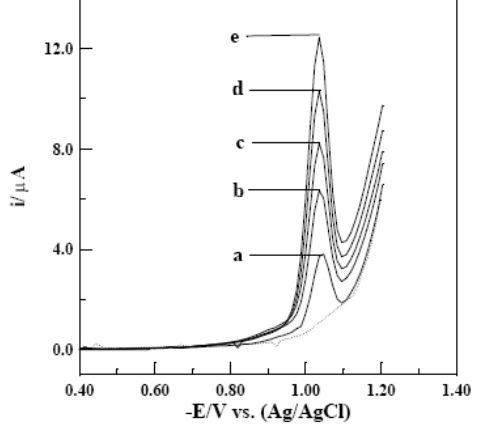
Fig. 6 SW-AdCS voltammograms for various concentrations of tolmetin spiked in human serum recorded after adsorptive accumulation onto the HMDE at E acc = − 0 . 4 V for t acc = 150 s. The dotted line represents the background, (a) 1 3 × 10 − 8 , (d) 4 × 10 − 8 and (e) 5 × 10 − 8 M tolmetin ( f = 120 Hz, Δ s = 12 mV and E sw = 50